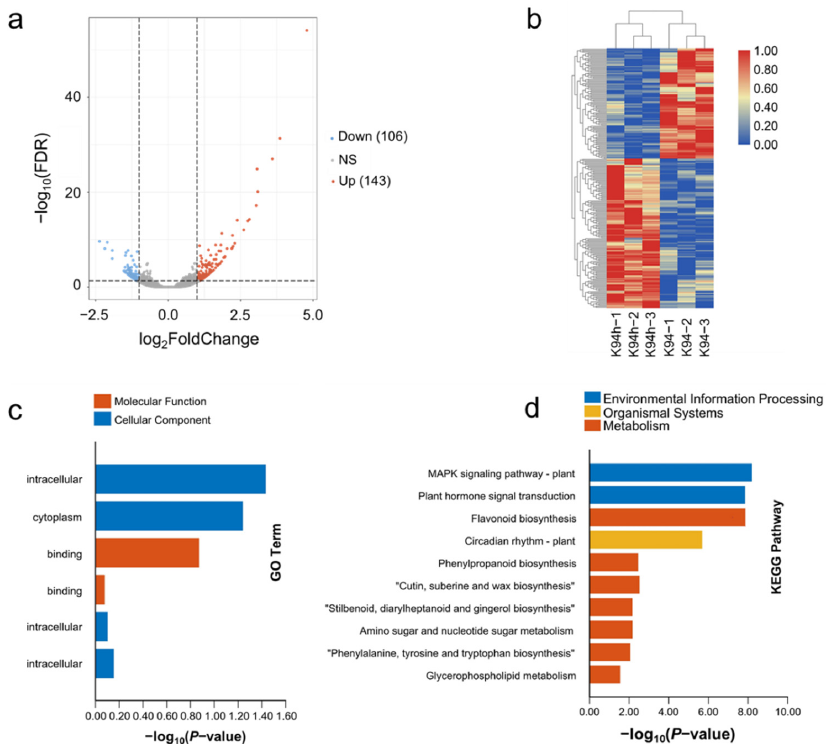
Figure 5. Identification and functional annotation of DEGs in treatment and control samples, generated using high-throughput deep sequencing technology. ( a ) Volcano plot showing the expression of the DEGs in the K94 versus K94h experimental comparison varieties. ( b ) Clustering analysis of DEGs in treatment and control samples. The scale bar indicates upregulated (red) and downregulated (blue) DEGs. The darker the color, the higher the expression; the lighter the color, the lower the expression. ( c ) The GO classification of all the DEGs of K94 cannabis in the seedling stage. ( d ) The enriched KEGG pathways of all the DEGs of K94 cannabis in the seedling stage.